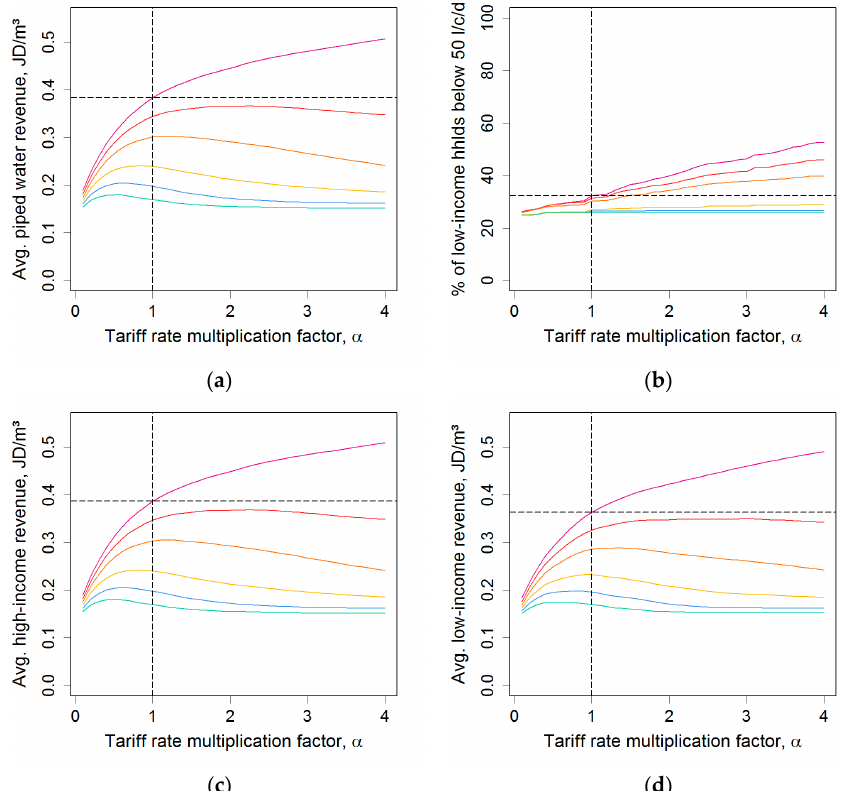
Figure 2. Results of simulation experiment 1, analyzing modifications of the 2013 IBT: For various levels of the tariff rate multiplication factor ( α ) , ( a ) shows the average revenue per m 3 paid by all households; ( b ) shows the percentage of low-income households consuming less than 50 L per person per day; and ( c , d ) show the average revenue per m 3 paid by high and low income households, respectively. The colored curves indicate the following levels of the tariff increase threshold ( γ ) , measured in m 3 per household per quarter: pink = 20; red = 30; orange = 40; yellow = 50; blue = 60; green = 70. The dotted lines indicate the baseline values reflecting the current situation. Axis labels: l/c/d = liters per capita per day; hhlds = households.